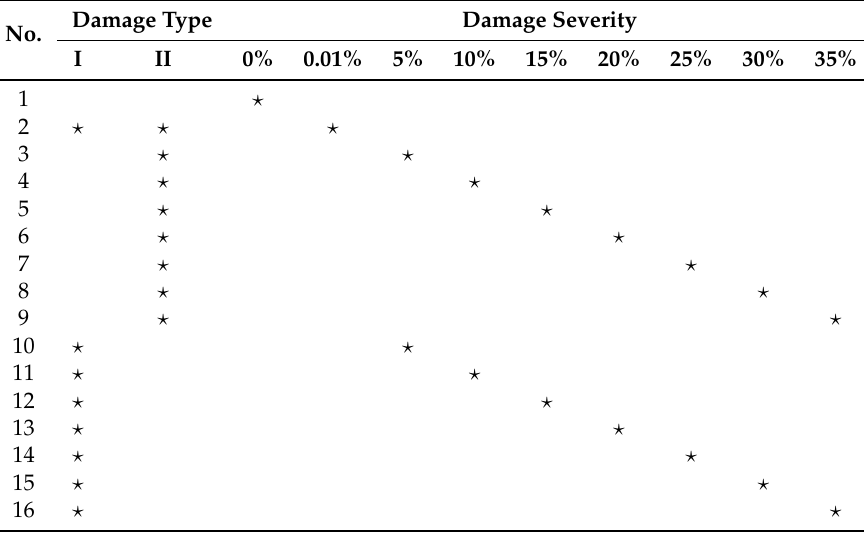
Table 1. Seismic damage scenarios for the